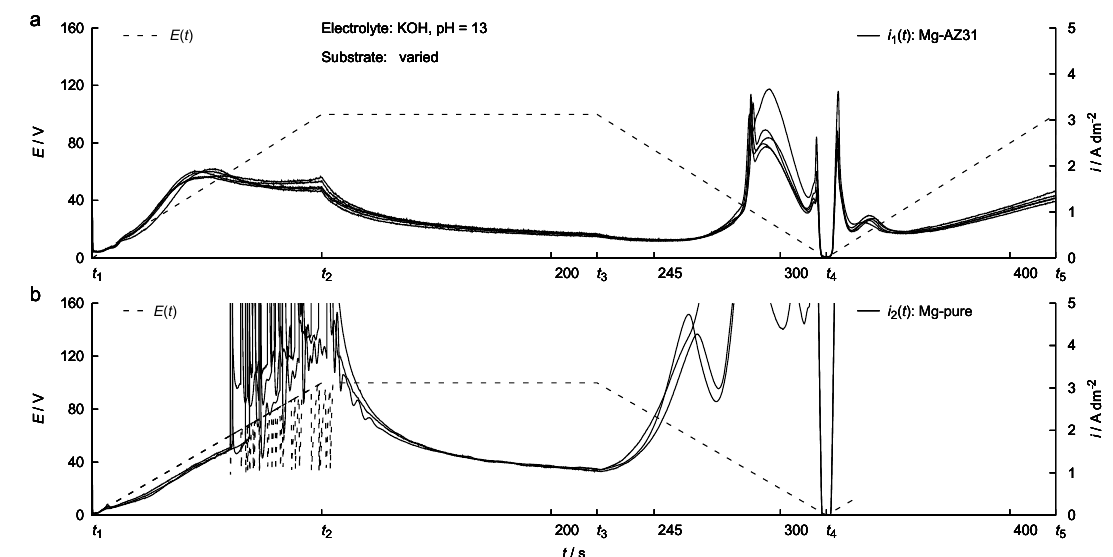
Figure 6. Results of polarisation experiments within KOH solution of pH = 13 on Mg-AZ31 ( a ) and technical pure magnesium ( b ), the curves for several repetitions of each measurement are shown.